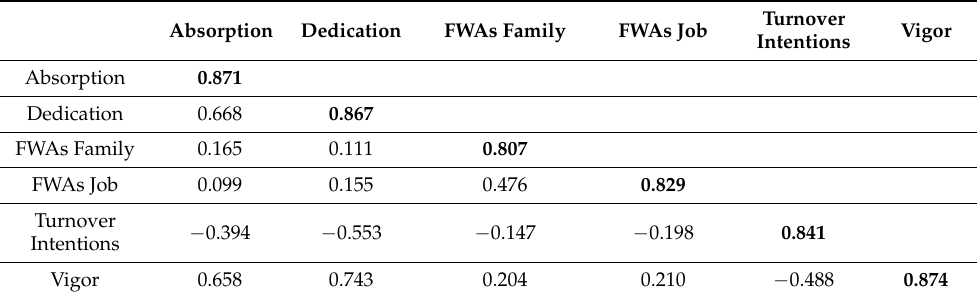
Table 9. Discriminant validity—Fornell–Larcker